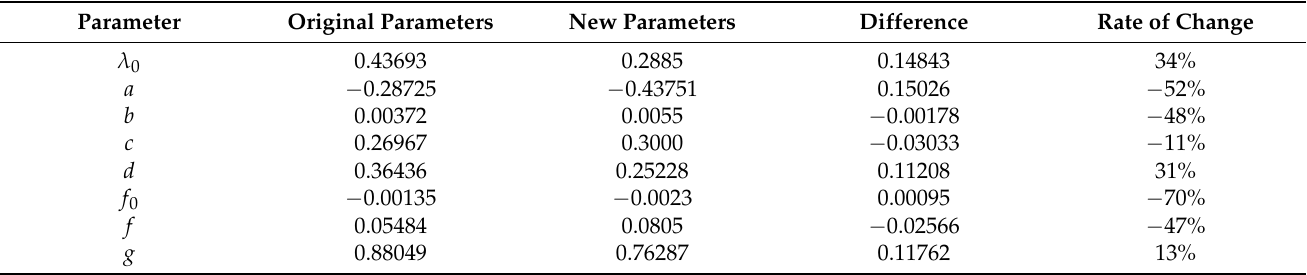
Table 2. Comparison between the parameters obtained with the method used in [19] and the new method